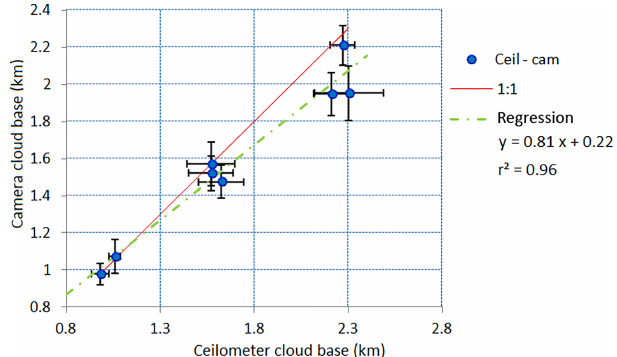
Figure 11. Comparison of mean cloud base height results obtained by the camera stereovision system and mean cloud base height re- sults obtained by the ceilometer (blue points). The red 1:1 line cor- responds to the reference plot. Linear regression for the ceilometer- camera plot is shown by the green dashed